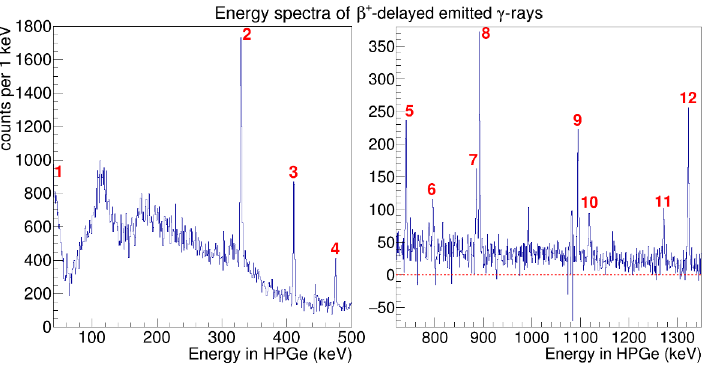
Figure 4. Sum-of-the-energy spectrum of the γ -rays emitted after the 46 Mn β + decay for all the HPGe crystals. The red numbers list the γ -rays peaks as they appear in the figure 23 of [7] The peaks 5, 6, and 10 have no energy levels assigned to them yet, while the peaks 8, and 9 are associated with 46 Cr ones. The other peaks are assigned to 45 V energy level